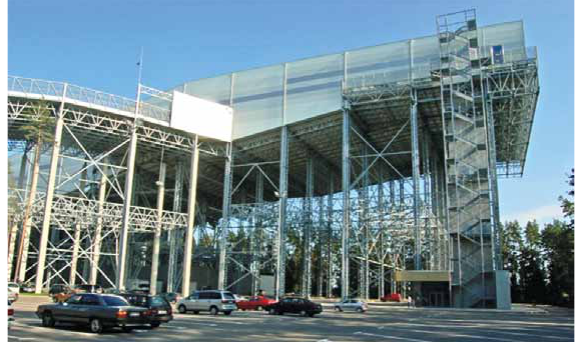
fig. 8. The realization of the project on Snow arena in